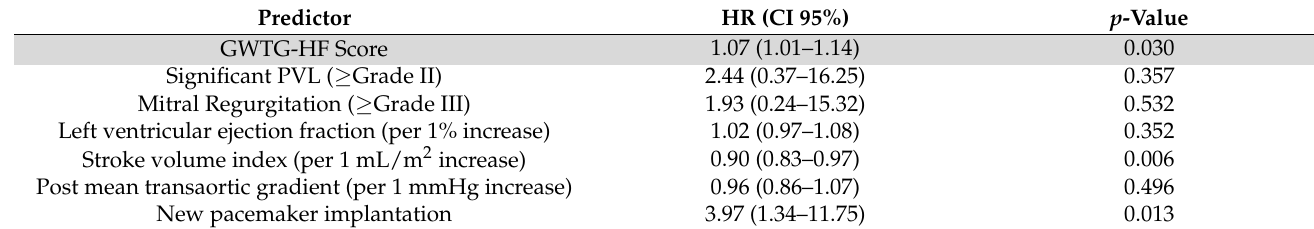
Table 4. Multivariate logistic regression (predictors for mortality after 1 year).